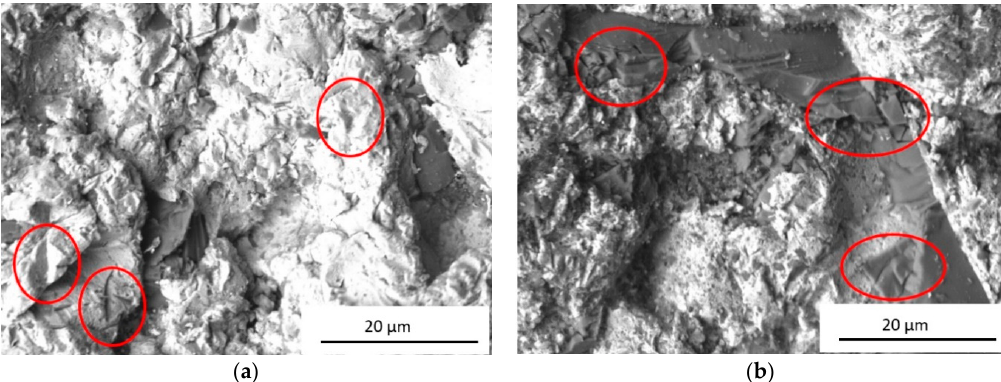
Figure 9. SEM micrograph of flat coatings surface, ECu/1/F ( a ) and ECu/2/F ( b ). Red circles mark indents in figure ( a ) and crushed SiC particles in figure ( b ).